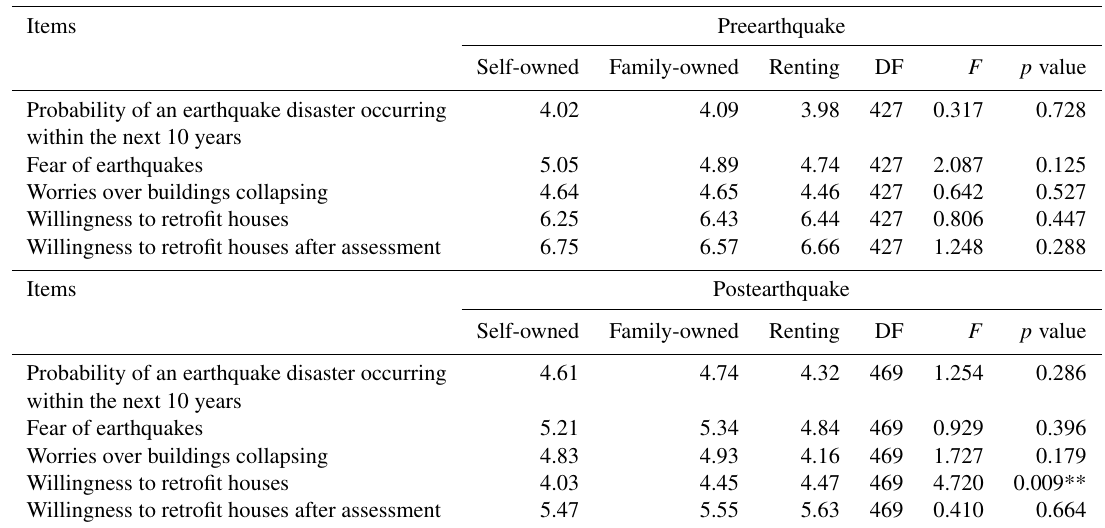
Table 9. p values and means for house